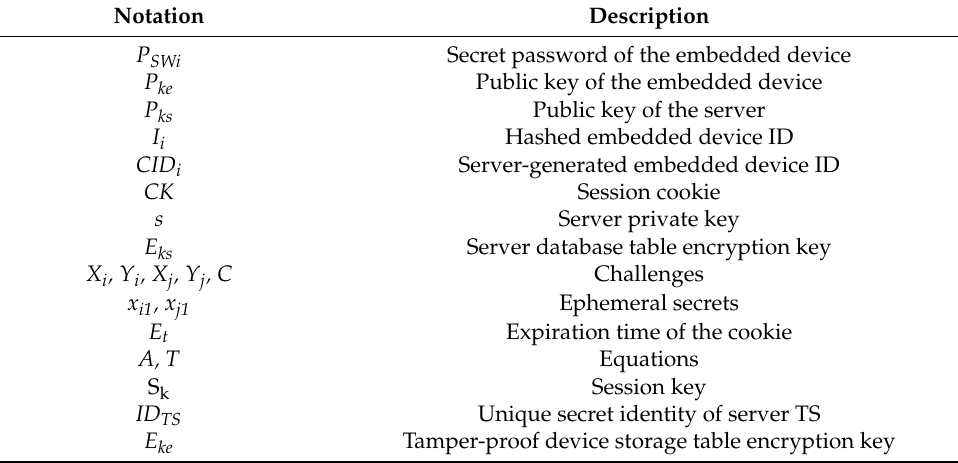
Table 1. Notation